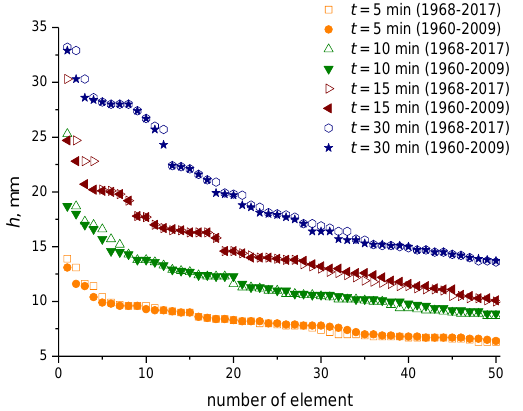
Fig. 1. Comparison of 5, 10, 15 and 30 minutes duration rainfall in the periods 1960–2009 and 1968–2017.